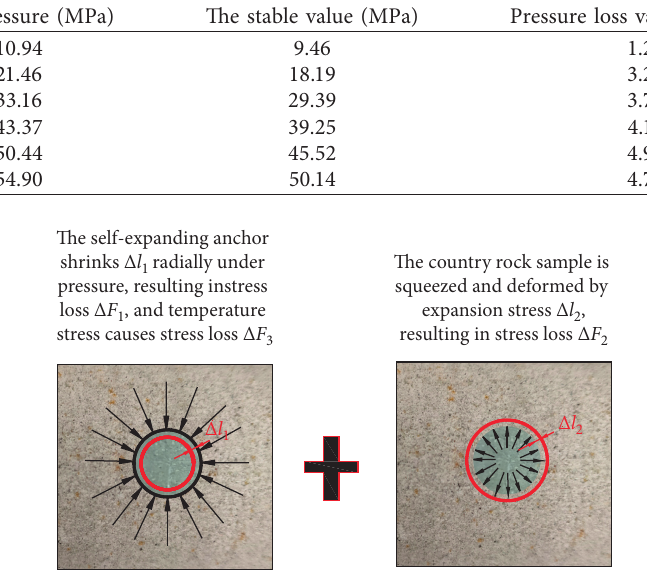
Figure 8: Schematic diagram of self-expanding anchor and surrounding rock stress.